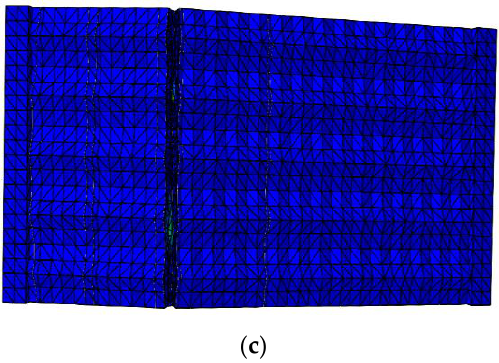
Figure 18. Graph of crack extension of a quadrilateral model: ( a ) crack occurrence stage; ( b ) crack extension stage; ( c ) final breaking stage.